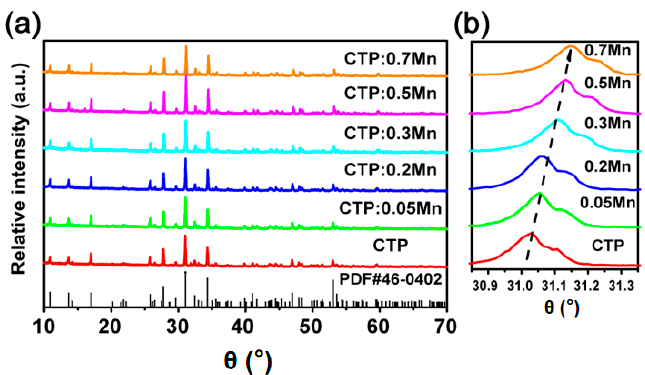
Figure 1. ( a ) Typically XRD patterns of CTP: x Mn 2+ together with the standard data, ( b ) The XRD patterns ranging from 30.8 to 31.4°. patterns ranging from 30.8 to 31.4 ◦